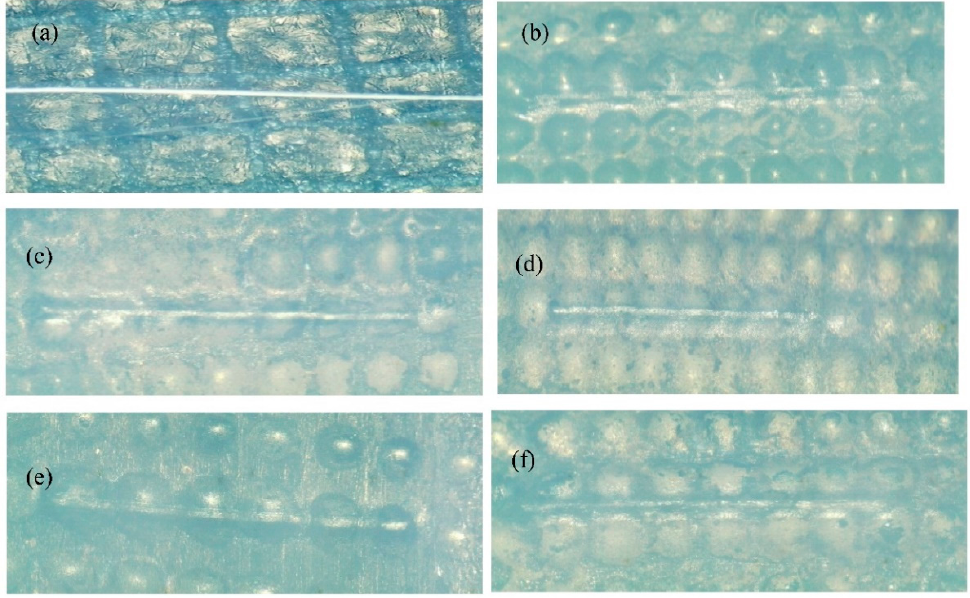
Figure 5. Scratch Test over the different samples ( a ) Nafion, ( b ) Nafion + Ag, ( c ) Nafion + Ag + CNT (0.01), ( d ) Nafion + Ag + CNT (0.05), ( e ) Nafion + Ag + Graphene (0.01) and ( f ) Nafion + Ag + Graphene (0.05).